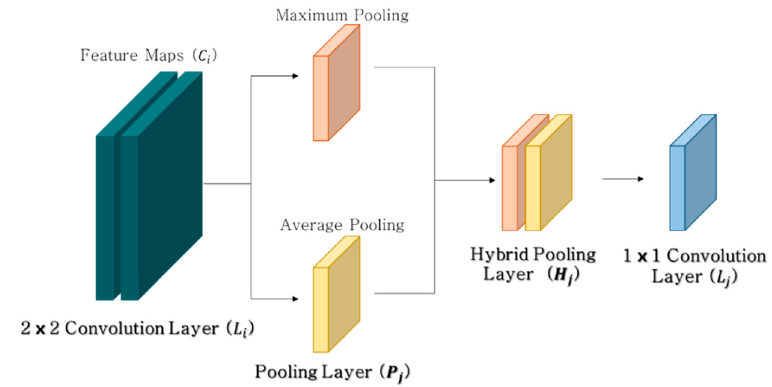
Figure 3. Hybrid pooling modules combining maximum and average pooling.